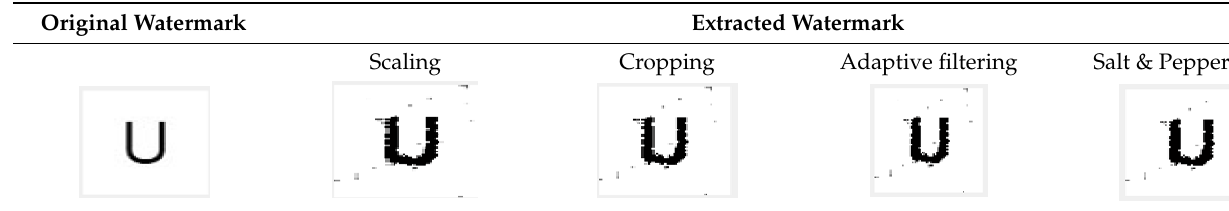
Figure 13. Salt and pepper noise on the watermarked image and extraction of the watermark after adding noise. Table 4. Comparison of extracted watermark with original watermark of size 64 × 64.